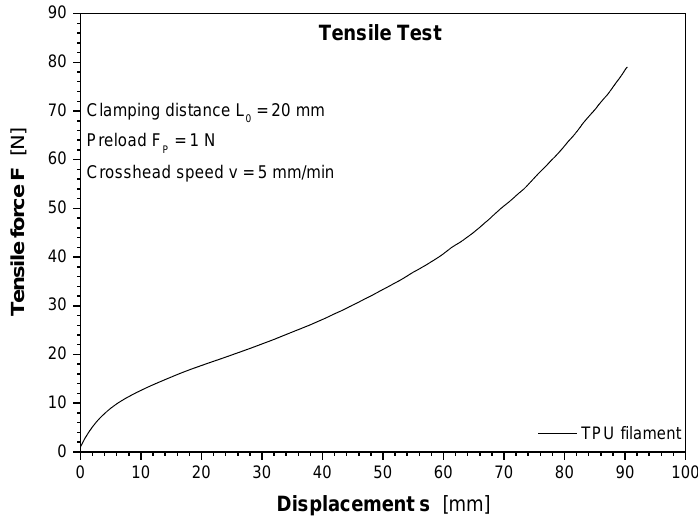
Figure 8. Force vs. displacement curve measured on the filament.